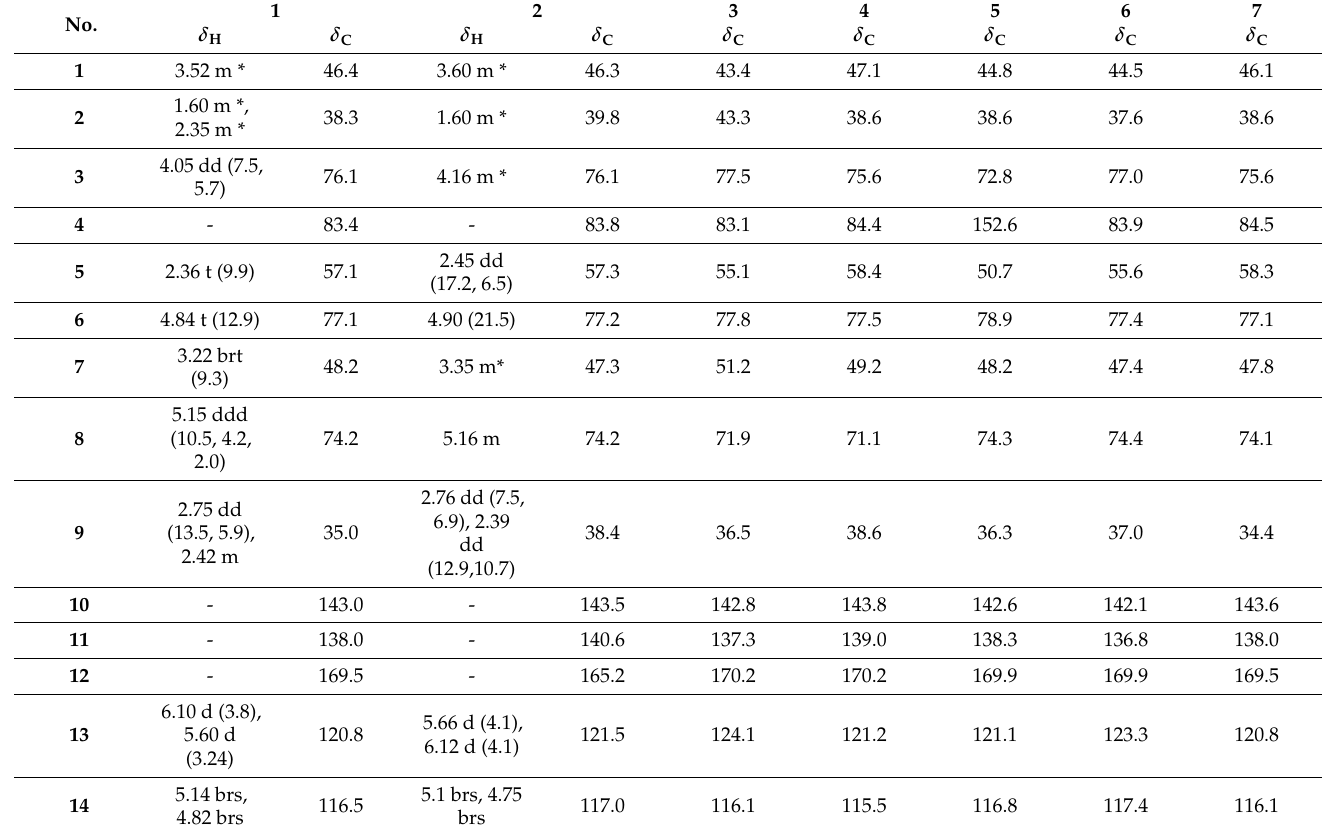
Table 1. 1 H and 13 C NMR data of compounds 1 – 7 in CDCl 3 (500 and 125 MHz δ in ppm, J in